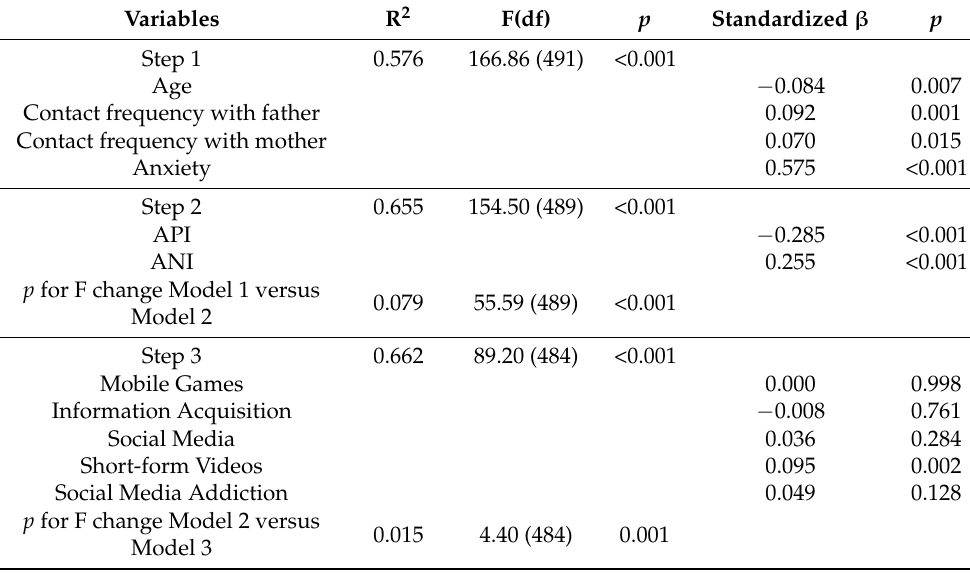
Table 3. Hierarchical multiple regression analyses for depression in girls ( n = 496).